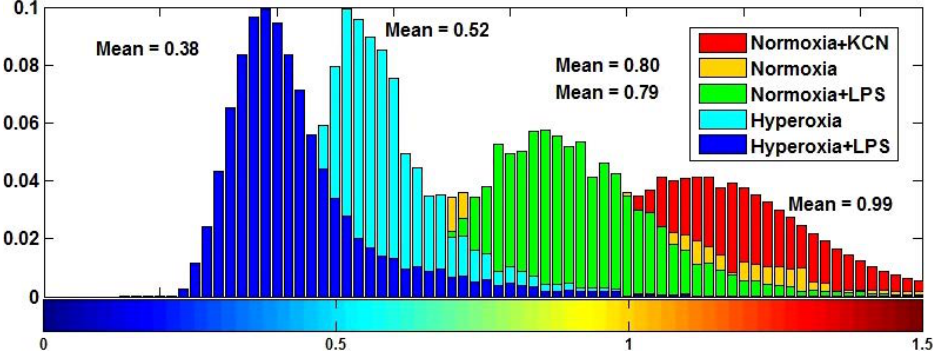
Fig. 3. NADH redox histograms for a representative lung in each group.